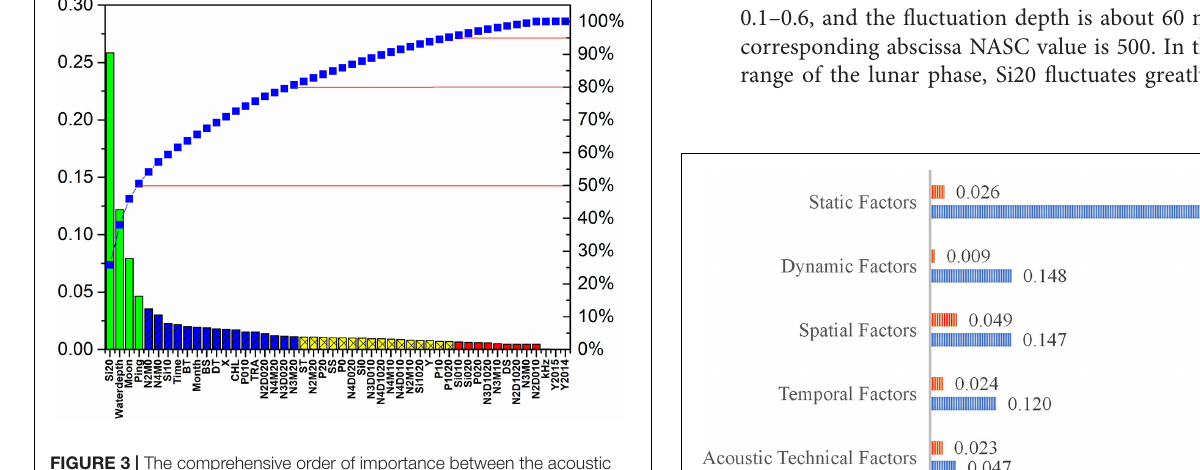
FIGURE 3 | The comprehensive order of importance between the acoustic density of fishery resources and the 48 factors of five major categories in the offshore ecosystem of the South China Sea. Green, blue, yellow, and red represent the first level to the fourth level, respectively, and the cumulative contribution rate ranges are 50, 80, and 95%, respectively.